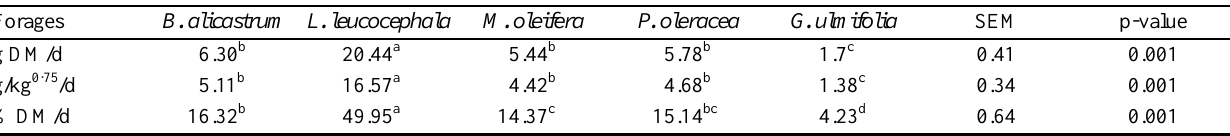
Table 3. DMI of the five forages when offered at the same time (n = 12 rabbits for each mean) Forages